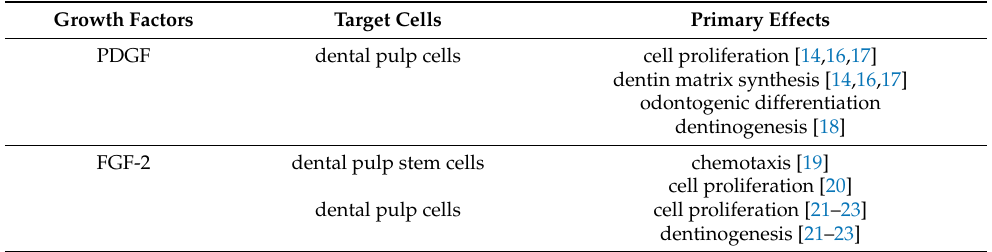
Table 1. Primary effects of FGF-2 and PDGF-BB for pulp regeneration.